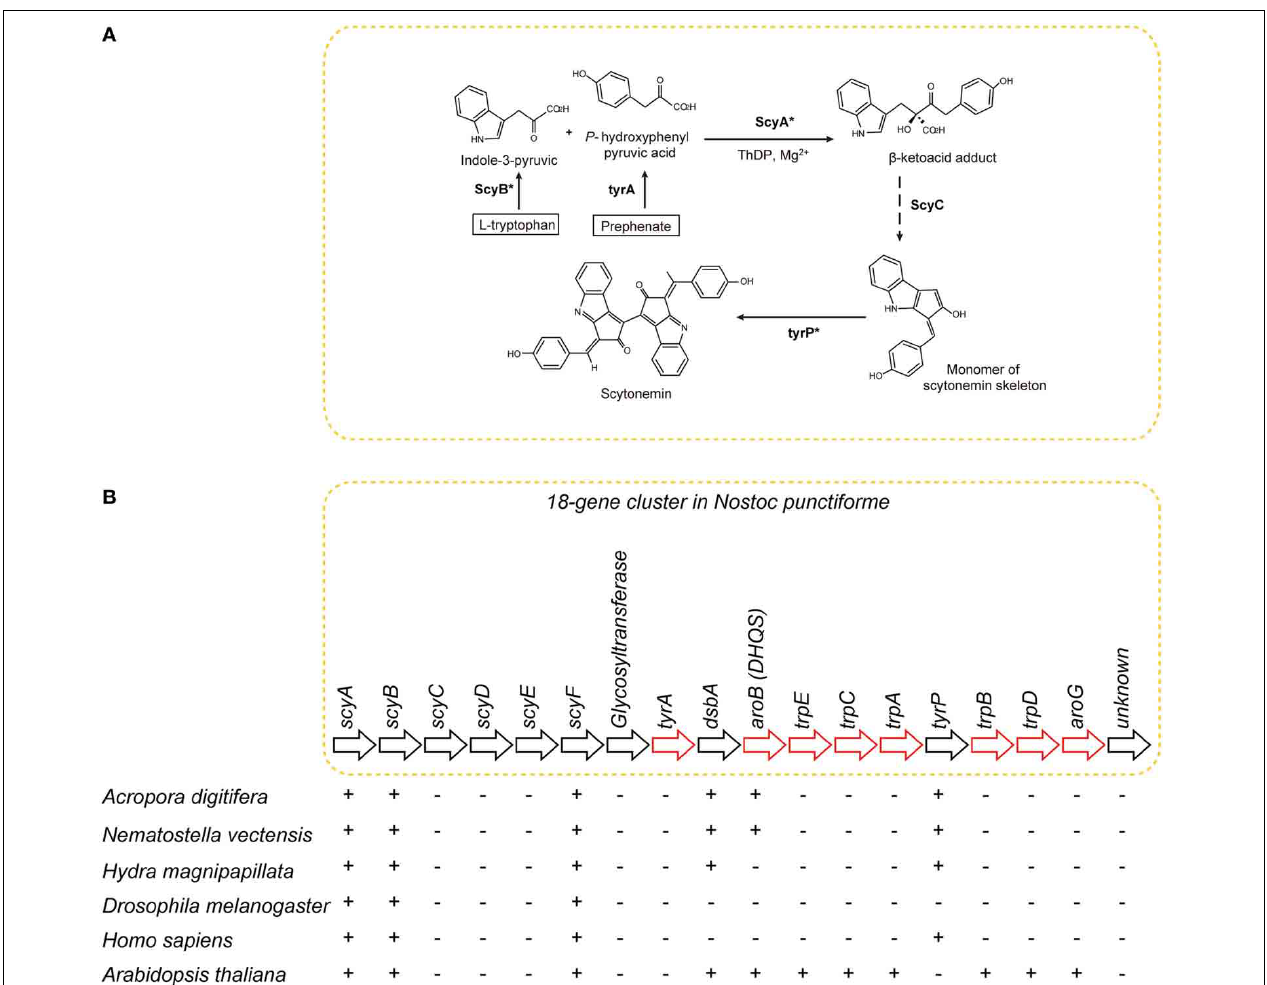
FIGURE 7 | The distribution of genes associated with biosynthesis of scytonemin in cyanobacteria, cnidarians, and other metazoans. (A) Pathways of biosynthesis of the photo-protective molecule scytonemin in the cyanobacterium Nostoc punctiforme (Soule et al., 2007; Rastogi et al., 2010). Genes encoding the enzymes indicated with asterisks were identified in the A. digitifera genome. (B) Schematics showing the organization of the